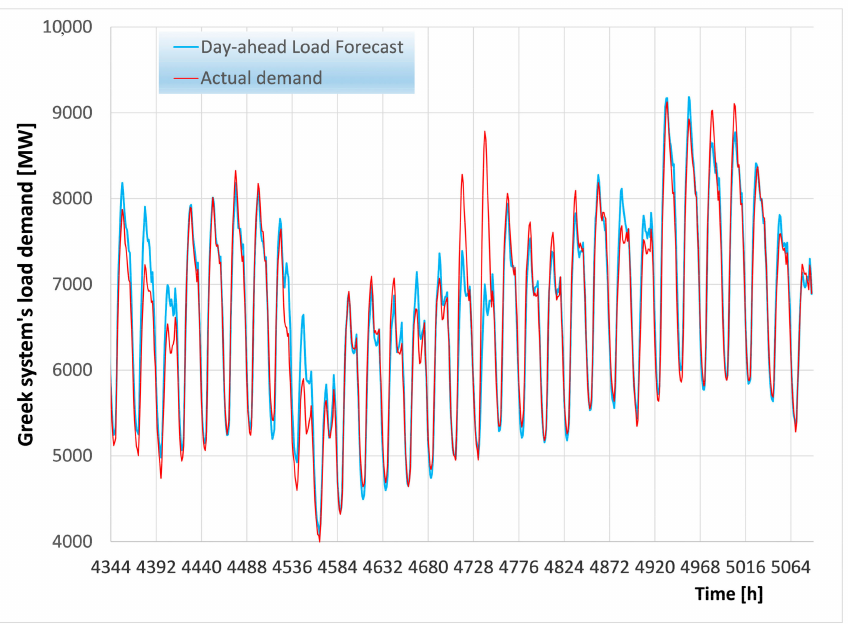
Figure 6. Greek system load during July 2022, day-ahead predicted versus actual values (MW) [35].